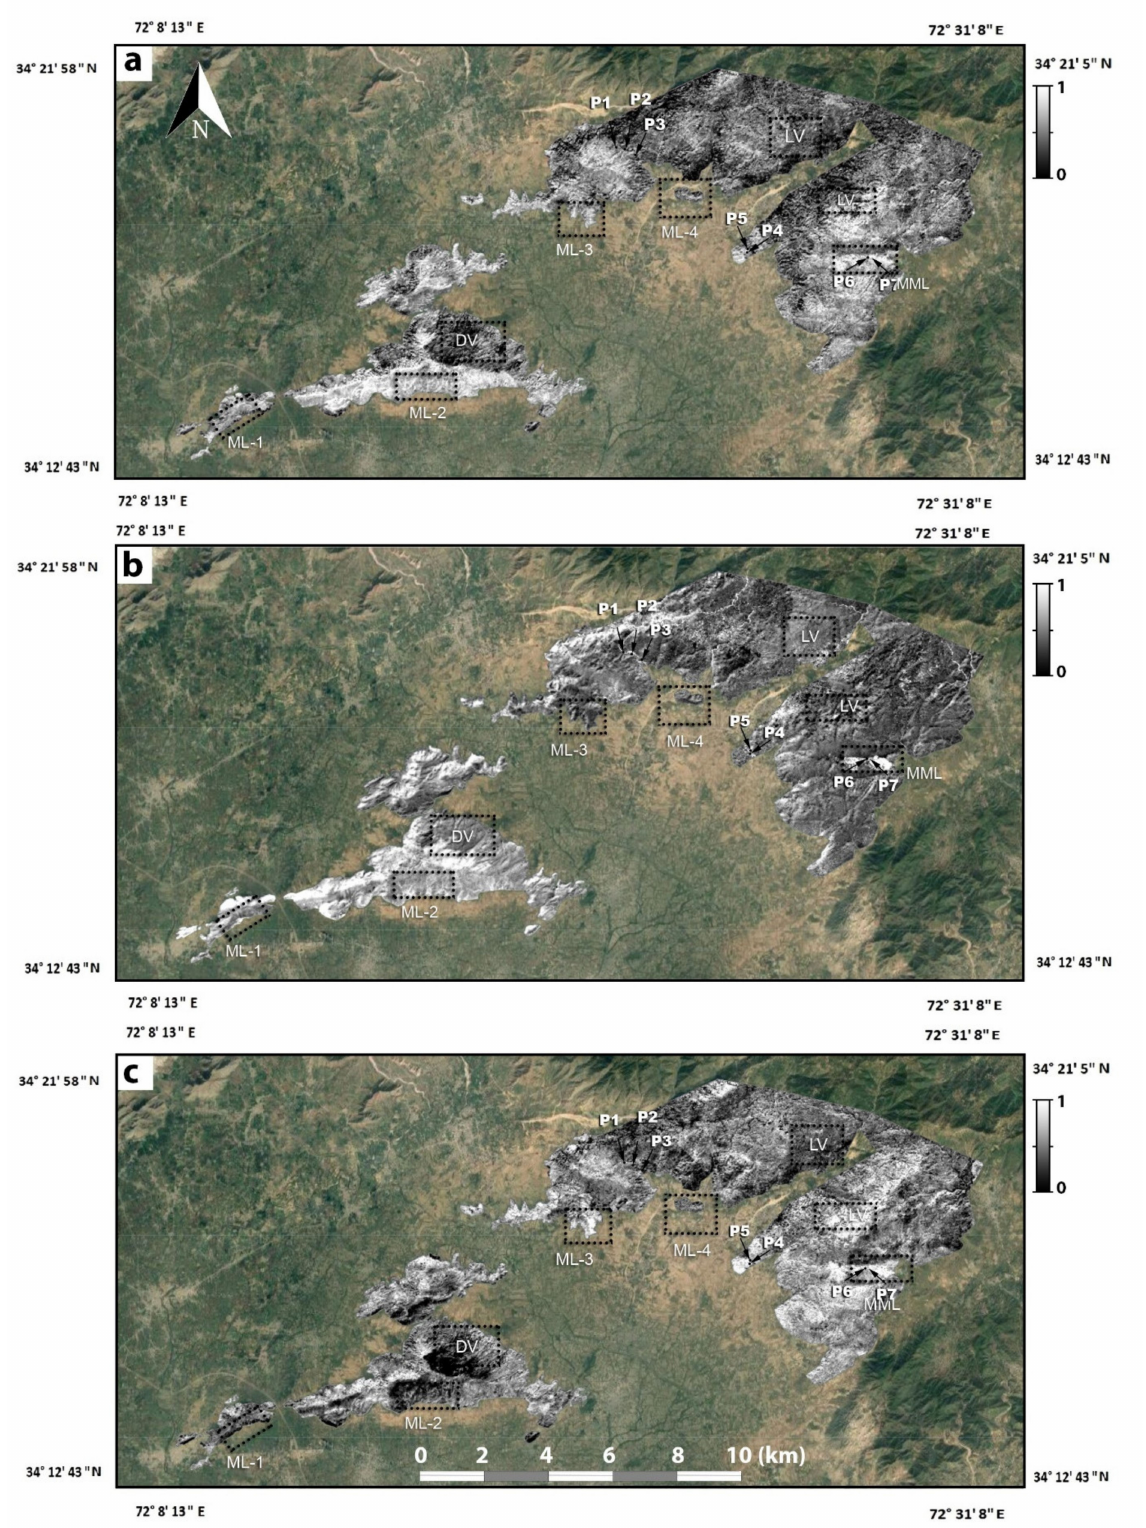
Figure 9. ( a ) PC3 of the stretched Sentinel-2 MSI data showing brighter and medium-toned granite and darker vegetation; ( b ) PC3 of the raw Sentinel-2 MSI data showing granite as medium-toned and vegetation in brighter pixels; ( c ) PC4 of the raw Sentinel-2 MSI data showing granite as brighter and medium-toned and vegetation in darker pixels. Marble is shown in brighter pixels in all these